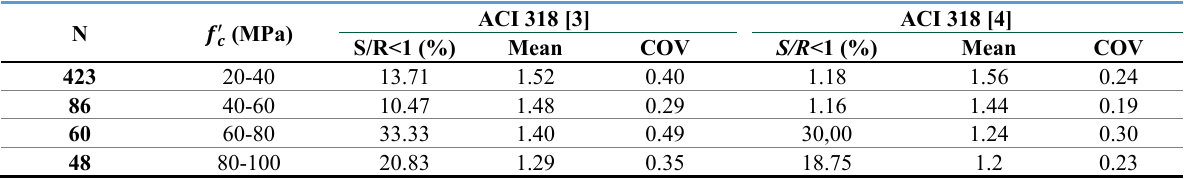
to ACI 318 [3] (yellow) and ACI 318 [3] 𝑐𝑐′ 𝑓𝑓